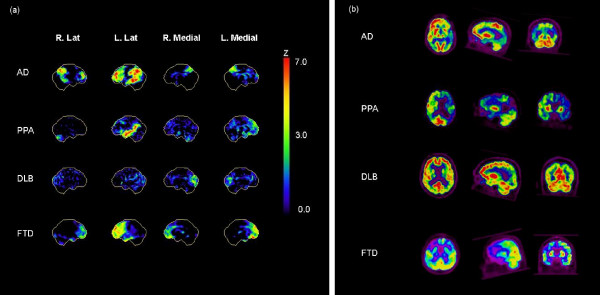
Case examples of AD, PPA, DLB and FTD: (a) Neurostat SSP – Z score maps, using a negative (hypoperfusion) colour scale and global normalisation; and (b) transaxial, sagital and coronal slices, centred on the area of maximal abnormality.